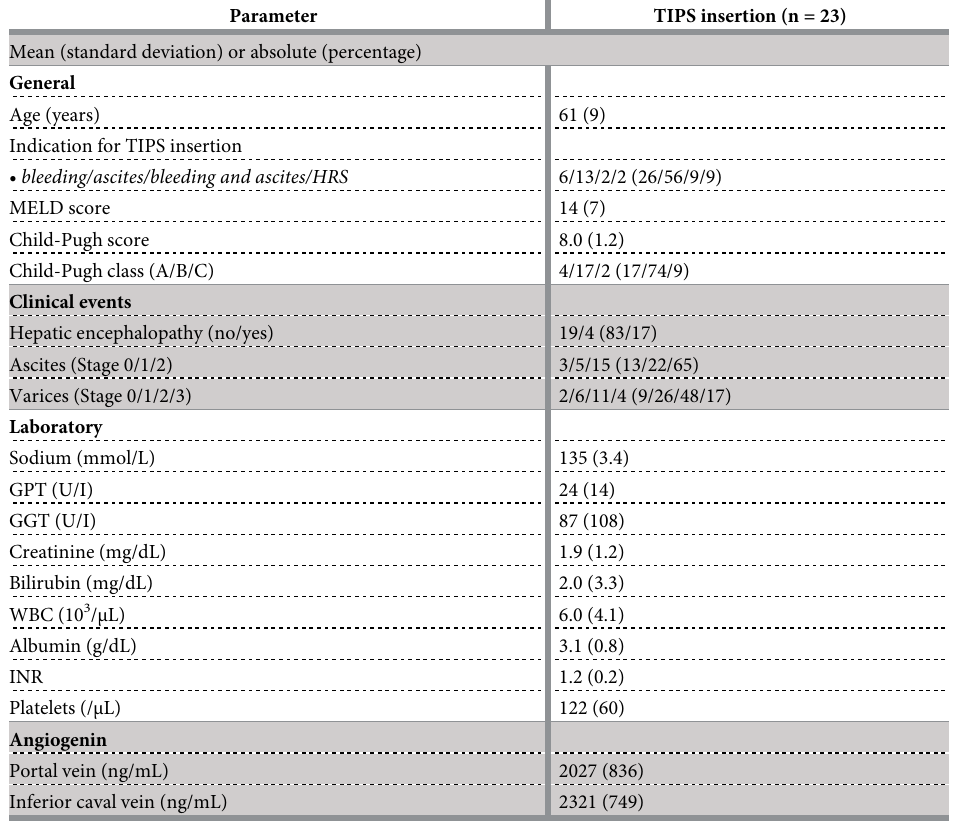
GGT: Gamma-glutamyltransferase; GPT: Glutamate pyruvate transaminase; HRS: Hepatorenal syndrome; INR: International normalized ratio; MELD: Model for end-stage liver disease; TIPS: Transjugular intrahepatic portosystemic stent shunt; WBC: White blood cell